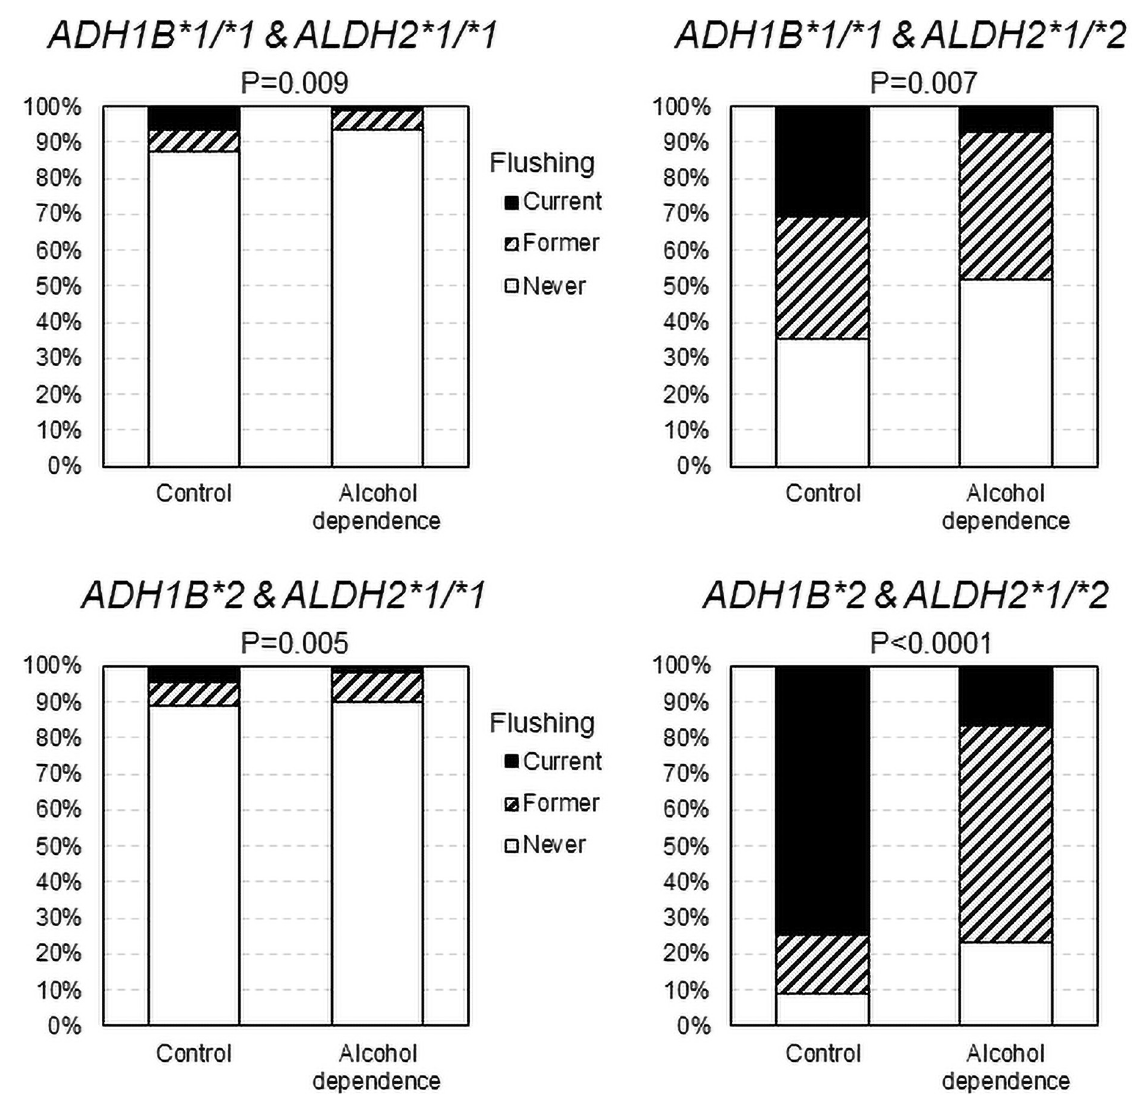
Fig 1. Comparison of the alcohol flushing between alcohol-dependent men and controls according to the combinations of ALDH2 and ADH1B genotypes. Never or former flushing was more frequently reported in the alcohol-dependent men than in the controls regardless of the ALDH2 and ADH1B genotype combination. Percentage values were adjusted for age by a direct method using the alcohol dependence group as the standard population; p values were by Cochran-Mantel-Haenszel test adjusted for age.